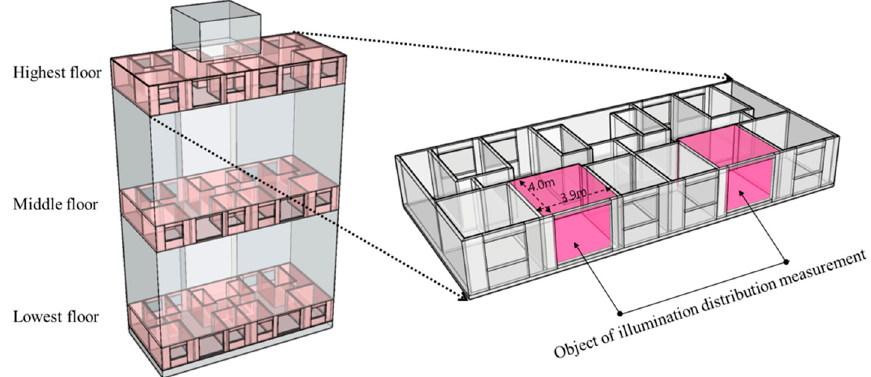
Figure 5. Object of natural lighting measurement. Table 3. Material properties for natural lighting.